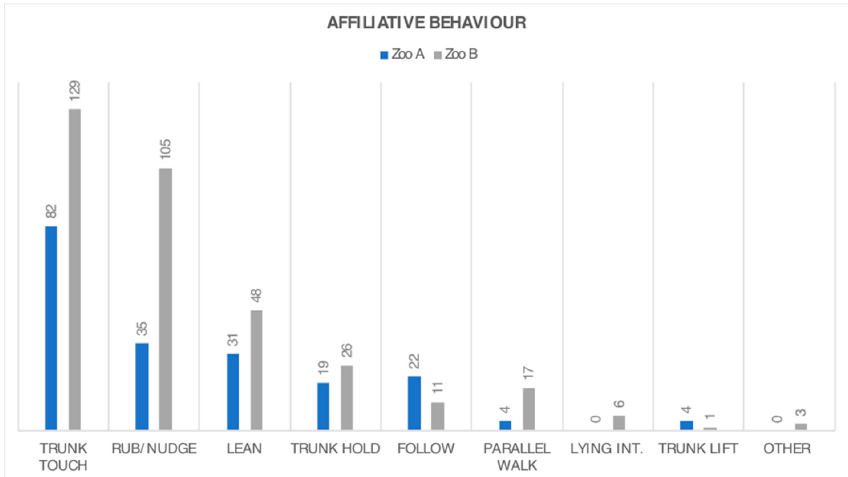
Figure 3. Frequency of observed affiliative interactions between the female elephants at Zoo A and B. Data from combined spring and autumn observations are given in terms of raw frequencies.